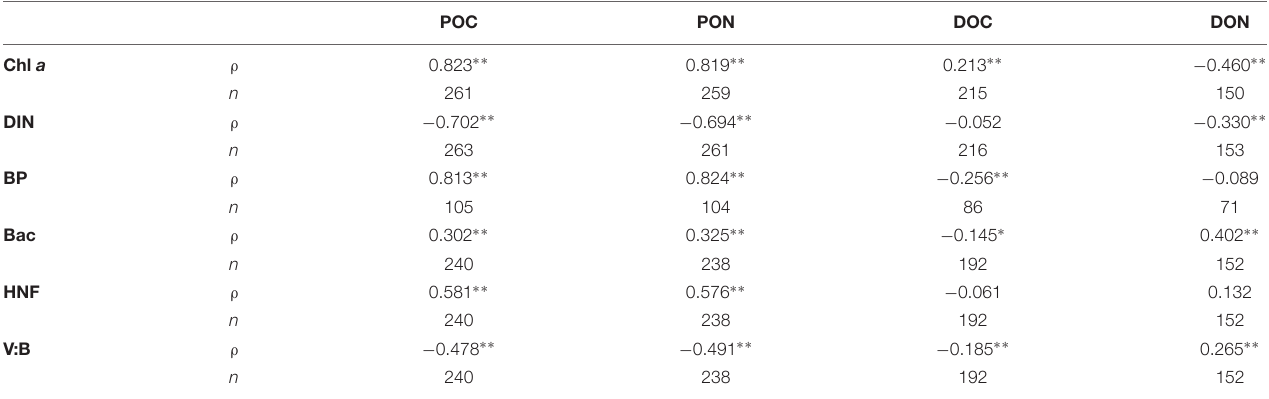
TABLE 2 | Correlation matric (non-parametric Spearman’s rho, ρ ) for particulate organic carbon (POC), particulate organic nitrogen (PON), dissolved organic carbon (DOC), dissolved organic nitrogen (DON), chlorophyll a (Chl a ), concentration of nitrate, nitrite and ammonium (DIN), bacterial production (BP), and abundance (Bac), as well as abundance of heterotrophic nanoflagellates (HNF) and the abundance ratio of bacteria to virus (V:B) for the annual dataset. POC PON DOC